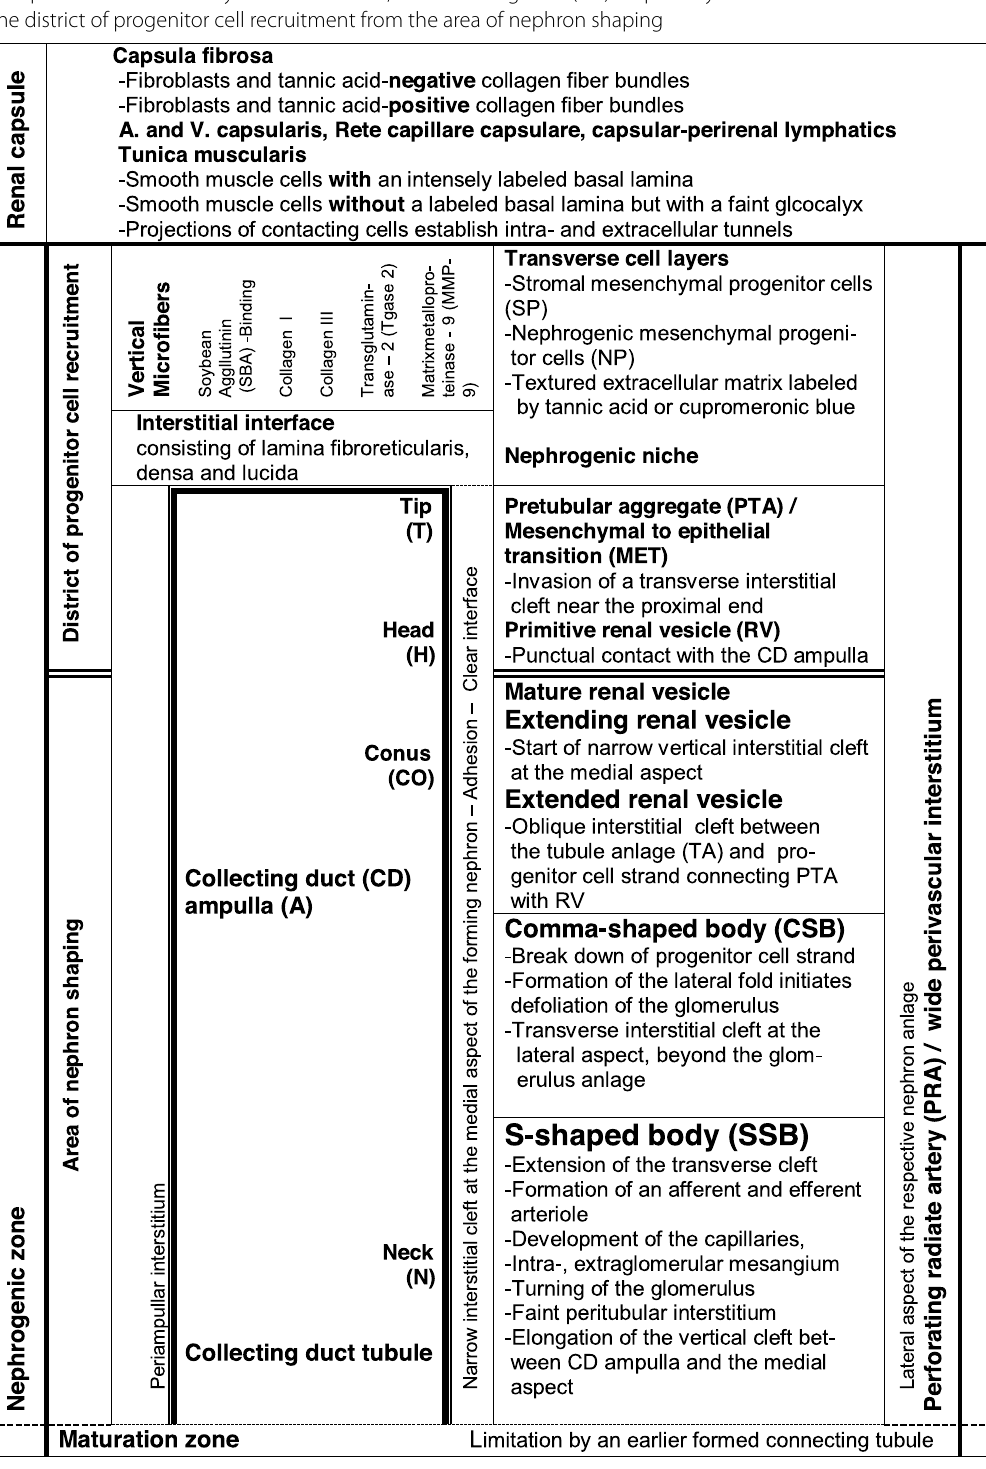
Table 1 List of interstitial sites at the forming nephron in the fetal human kidney during advanced pregnancy. The nephrogenic compartment is marked by a thick black line, the collecting duct (CD) ampulla by a thick/thin line. The transverse double line separates the district of progenitor cell recruitment from the area of nephron